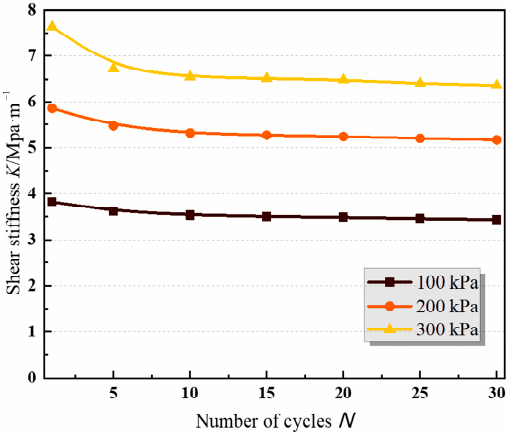
Figure 17. Shear stiffness–cycle number curve under different normal stress conditions.